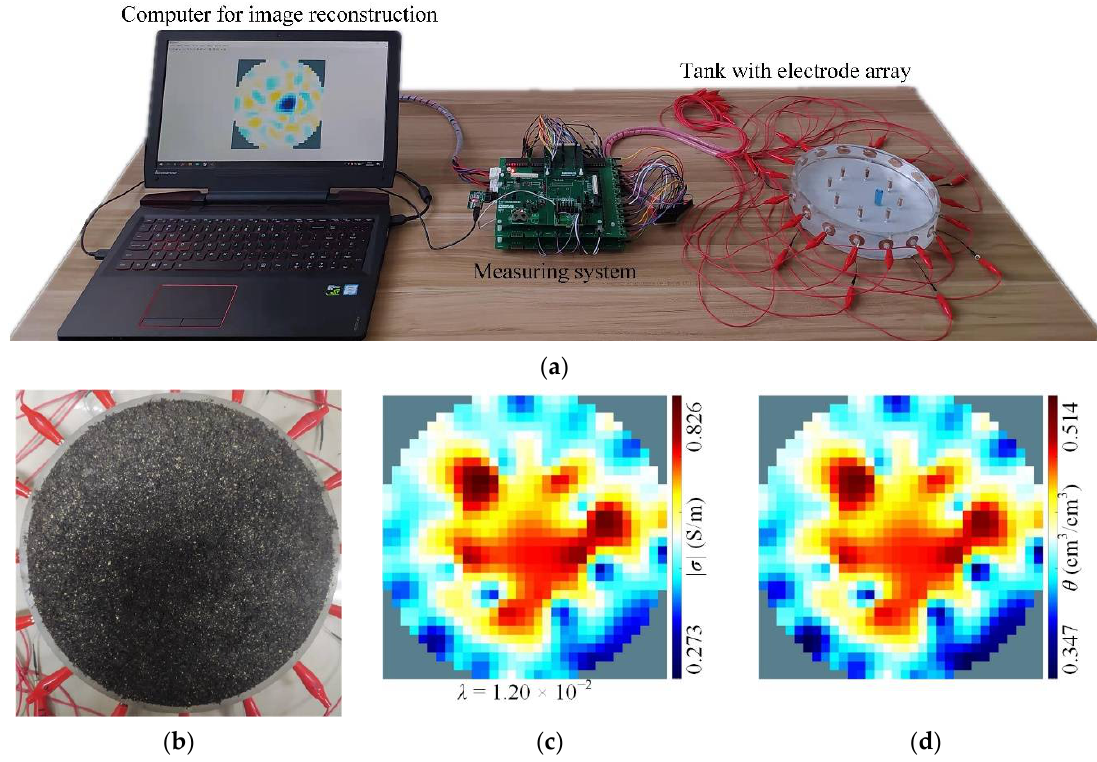
Figure A8. Exemplary application of a moisture–conductivity relation for mapping of moisture in a substrate zone, using electrical imaging. ( a ) Photograph of the experimental setup; ( b ) photograph of the substrate zone; ( c ) reconstructed image of the conductivity distribution; ( d ) image of the moisture distribution.